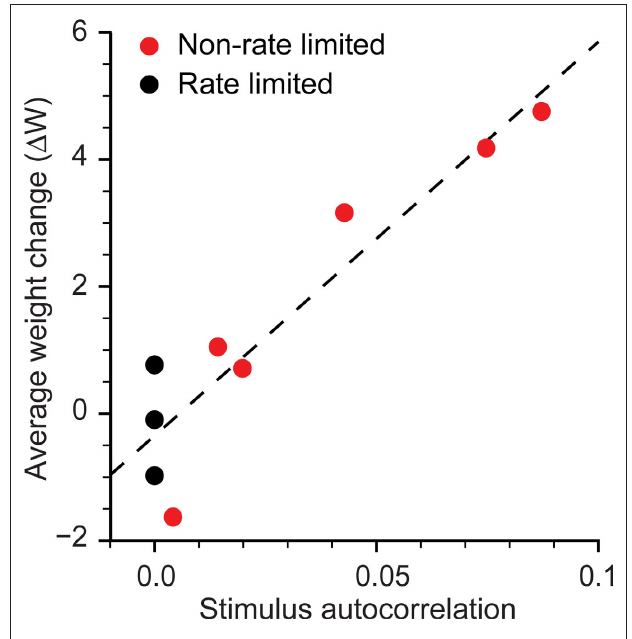
Figure 8 | effect of stimulus autocorrelation on network-wide potentiation. For all experiments at 5-ms latency (red), the average connectivity change ∆ W for non-targeted connections had a linear dependence on the autocorrelation of the stimulus train averaged over lags from 20 to 100 ms. Average weight changes for the rate limited experiments with an enforced autocorrelation of 0 (black) are clustered around